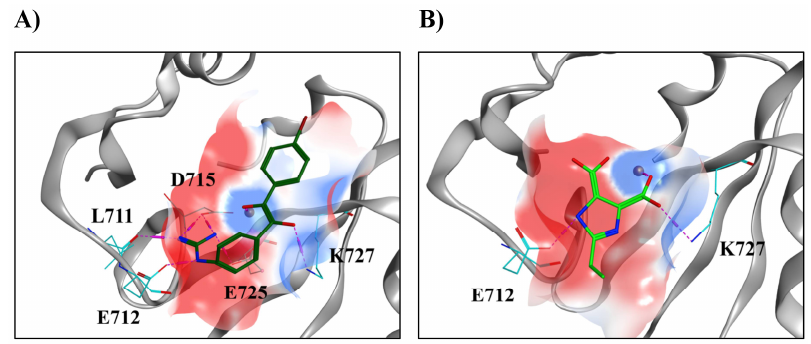
Figure 5. Binding modes of two promising hits derived from the virtual screening (VS). ( A ) ZINC000049131978, hit #5 (carbon, nitrogen and oxygen atoms represented in dark green, blue and light red, respectively). ( B ) ZINC000038550857, hit #13 (carbon, nitrogen and oxygen atoms represented in light green, blue and light red, respectively). Carbon, nitrogen and oxygen atoms of the active site are represented in cyan, blue and light red, respectively. The Mg 2+ ion is represented as a dark red sphere. Hydrogen bonds are represented in purple dotted lines. The surface of the active site is colored depending on the electrostatic potential, ranging from −40 kcal/mol (intense red) to +40 kcal/mol (intense blue). See text for a detailed description of the electrostatic interactions.